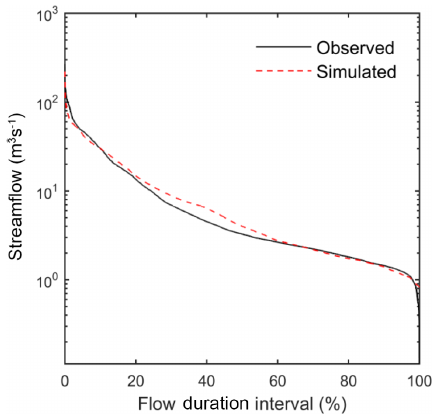
Figure 5. Flow duration curve at the Mouth of Canyon for the entire simulation